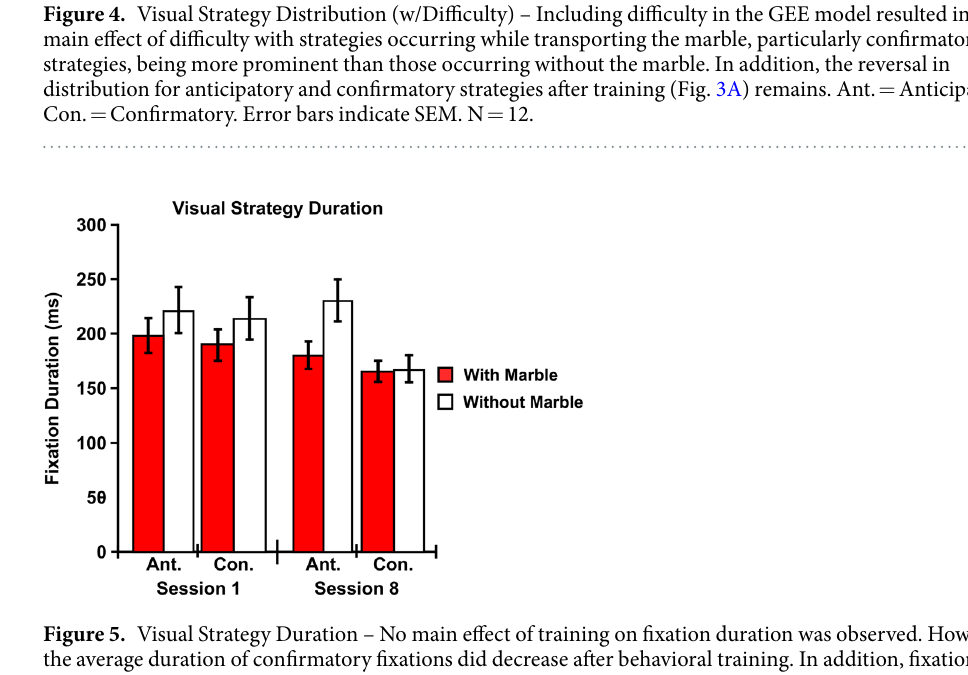
Eye-Tracking Results: Visual Strategy Duration.